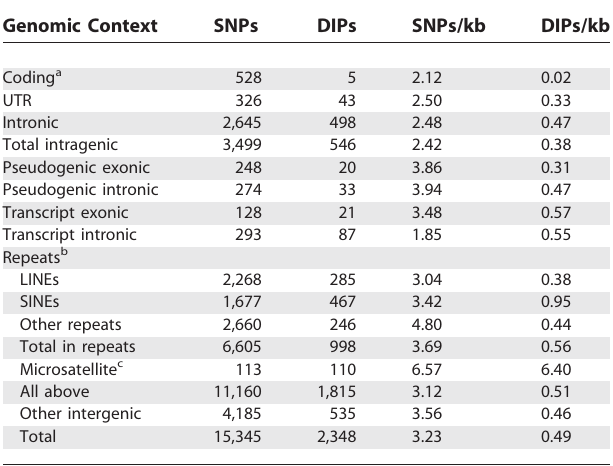
Table 1. Sequence Variations between QBL and PGF Genomic